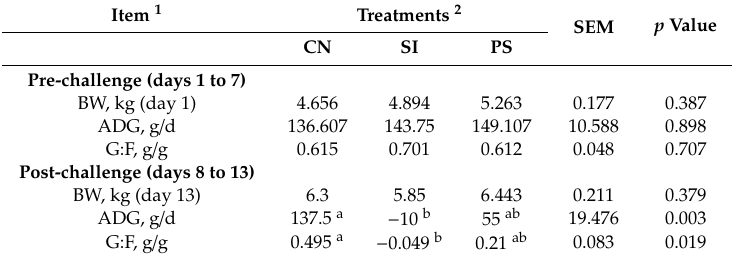
Table 1. E ff ects of oral administration of LBB-mix on the growth performance of weaned piglets before and after S . Infantis